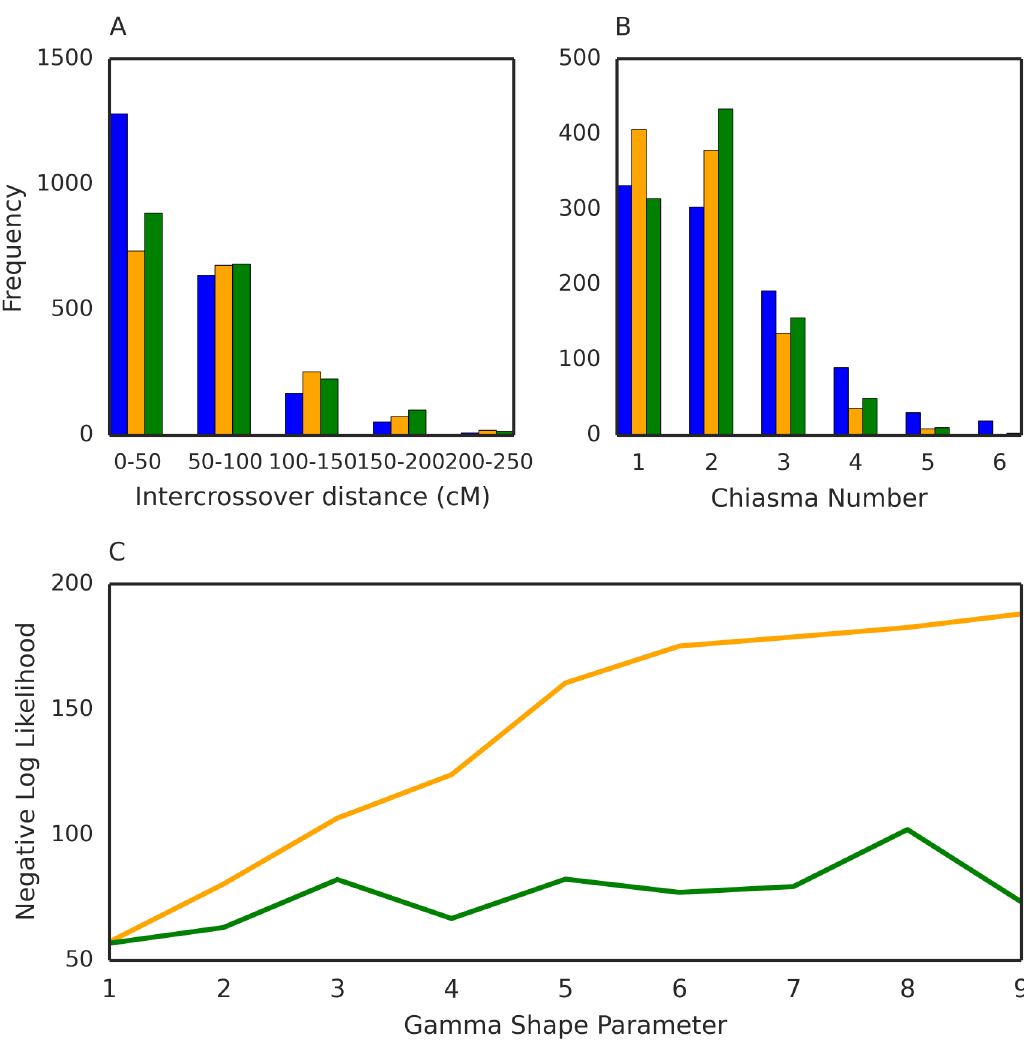
Fig 1. Meiosis simulations. Blue indicates data obtained from the progeny of strains crossed in the laboratory. Orange indicates simulated data using the non-obligate chiasma meiosis model while green indicates simulated data from the obligate chiasma meiosis model. A ) Barplots of the intercrossover distances of all 14 chromosomes of the P . falciparum genome. B ) Barplots of the number of chiasma scattered throughout the genome. For A and B , simulated data were generated using a shape parameter of 2. C ) Line plots of the negative pseudo-likelihood values of the non-obligate and obligate meiosis models at different levels of crossover interference. Along the x-axis are different levels of crossover interference (determined by the value of the shape parameter). A shape parameter of 1 indicates no crossover intereference. Lower negative pseudo-likelihood values indicate a better fit to the data obtained from the progeny of experimentally lab-crossed strains.